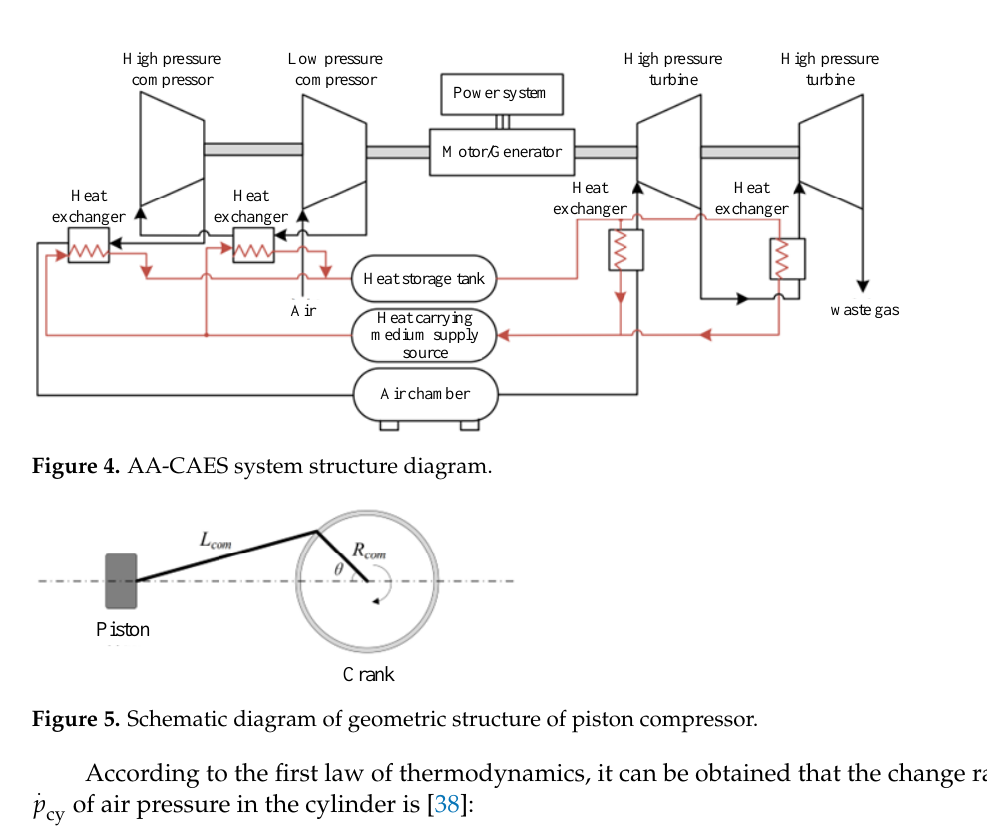
Figure 5. Schematic diagram of geometric structure of piston compressor.